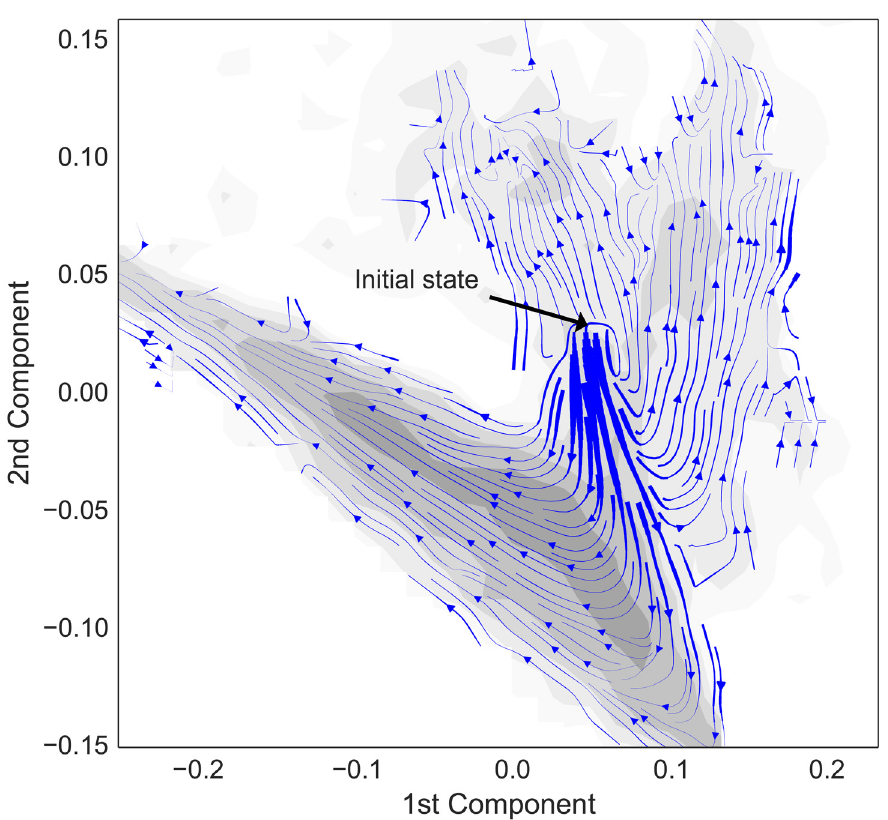
Fig 7. Flow diagram of GARD dynamics in heritable-state space. This figure shows the average time- dependent behavior of the system state for a particular choice of the β matrix and a distribution of selection pressures, projected onto the first two PCA eigenvectors. The thickness of the streamlines indicates the magnitude of the vectors in the underlying averaged vector field. As the mean vector field is the result of averaging a number of random walks, this can be thought of as the strength of the local bias. The underlying greyscale intensity shows the logarithm of the probability density for the system state being found at that